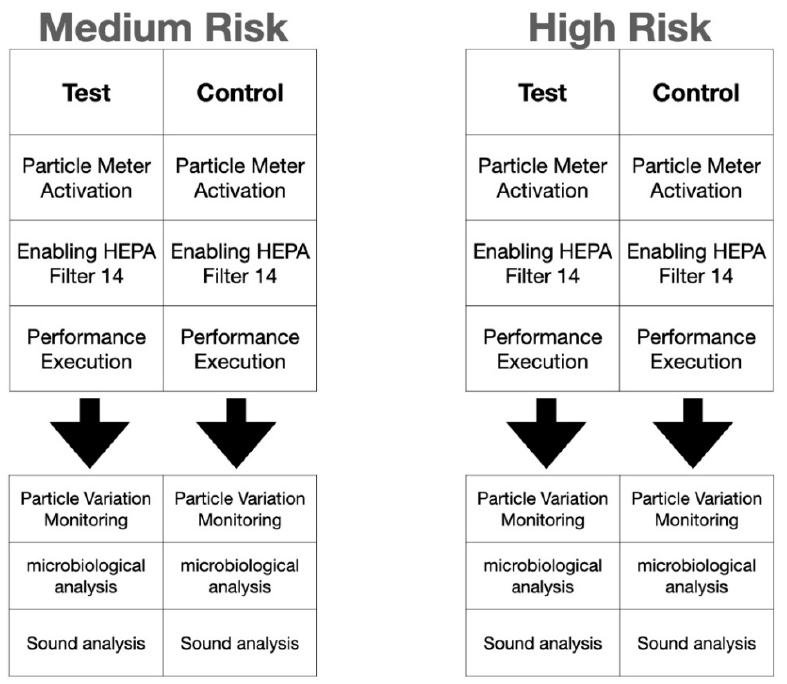
Figure 2. Description of medium- and high-risk groups. HEPA = High Efficiency Particulate Air Filter.